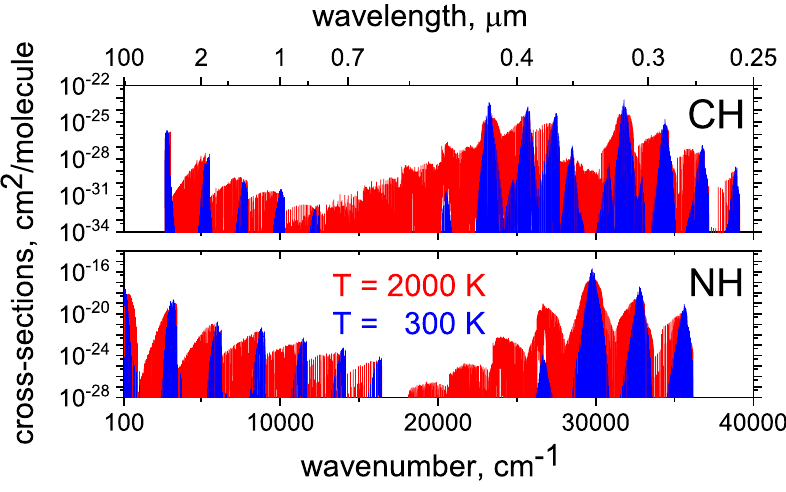
Figure 2. Cross sections of CN and NH computed using line lists by